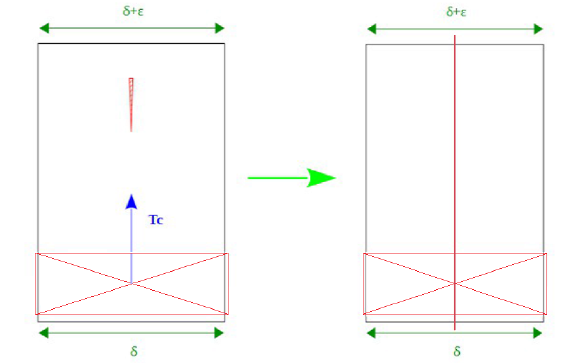
Figure 5: Solving the problem (left) by reducing the inner-fit polygon dimension, here to a line for example (right).